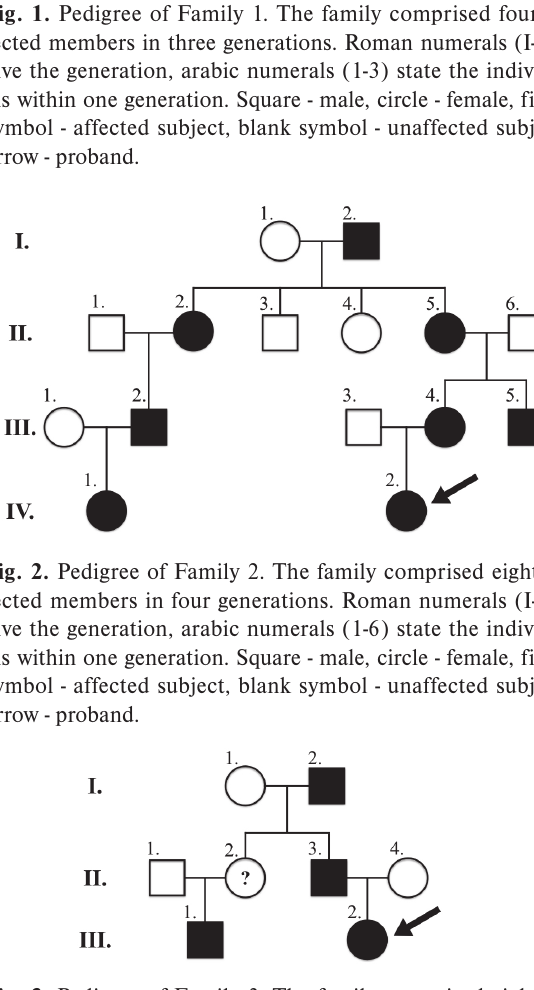
Fig. 3. Pedigree of Family 3. The family comprised eight af- fected members in four generations. Roman numerals (I-III) give the generation, arabic numerals (1-4) state the individuals within one generation. Square - male, circle - female, filled sym- bol - affected subject, blank symbol - unaffected subject, arrow - proband, question mark - unknown